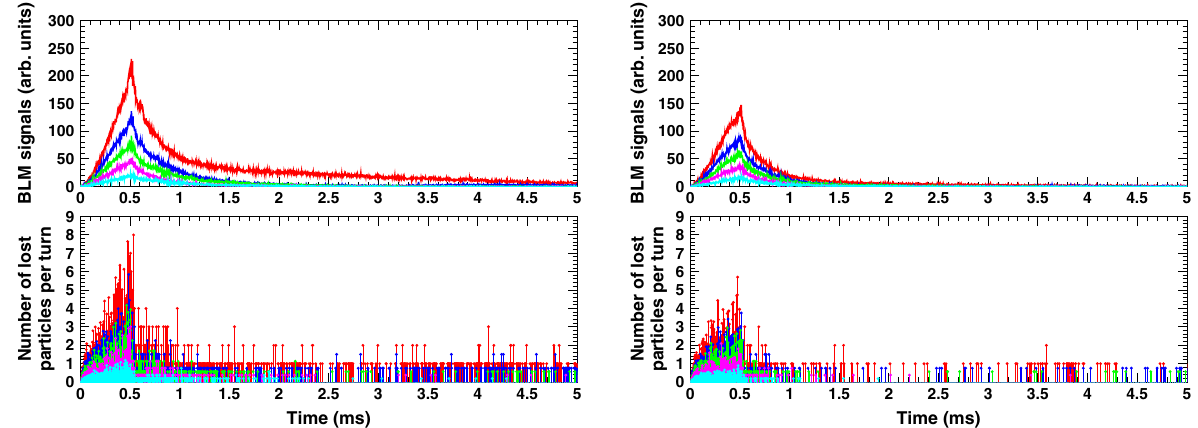
FIG. 22. (Left) Scintillation-type BLM signals over the first 5 ms measured at the collimator section with various beam intensities of 107 (light blue), 214 (pink), 322 (green), 429 (blue), and 573 (red) kW before the correction of the injection beam Twiss parameter (upper), and the corresponding numerical simulation results (lower). (Right) Similar results obtained after the correction of the injection beam Twiss parameter.